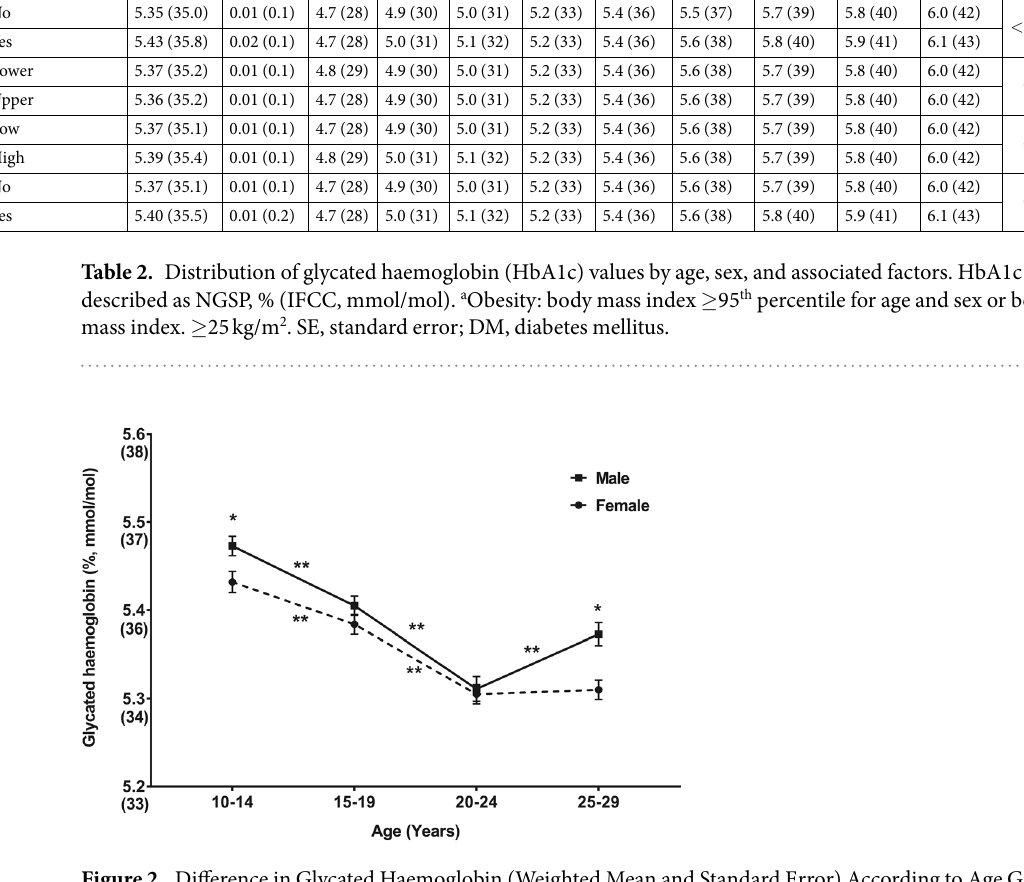
such as insulin resistance, may have a greater influence on the HbA1c level. As age increased, HbA1c tended to decrease, reaching the minimum value in the 20–24-year-old age group. The value increased again in male sub- jects aged 25–29 years, but remained stable in female subjects. In all age groups except 20–24 years, male subjects had higher HbA1c values than female subjects. HbA1c values were higher in those with a history of parental diabetes; given that these subjects have a genetic predisposition to developing DM, HbA1c levels may be affected by such a factor. In the present study, household income level and parental educational level, representing socio-economic status, showed no statistically signifi- cant correlations with HbA1c values. HbA1c is used as a diagnostic criterion for diabetes and prediabetes; the cut-off values generally applied for prediabetes and diabetes are 5.7% (39 mmol/mol) and 6.5% (48 mmol/mol), respectively, but in the present study, 5.7% (39 mmol/mol) corresponded approximately to the 90 th percentile value, while 6.5% (48 mmol/mol) corre- sponded to over the 99 th percentile value. According to data from the USA 8 , the 90 th and 95 th percentile values for those aged 5–24 years are 5.39% and 5.52%, respectively, which are lower than the values for Koreans obtained in the present study. The cut-off value for prediabetes in the present study, corresponding to the 90 th percentile value, bears sufficient statistical significance, and since the cut-off value for diabetes well exceeded the 99 th percentile value, applying an HbA1c value of 6.5% as a diagnostic criterion for DM in youths and young adults in Korea would yield higher positive predictive values and specificity than in other ethnicities.